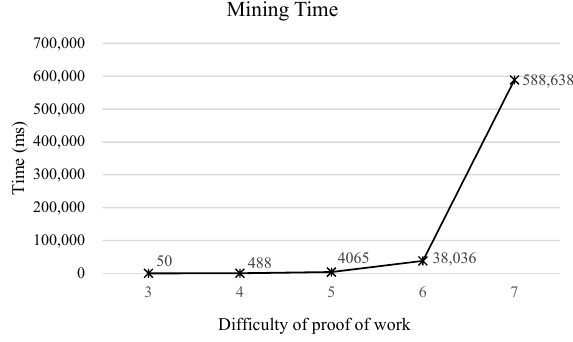
Figure 3. Mining Time.